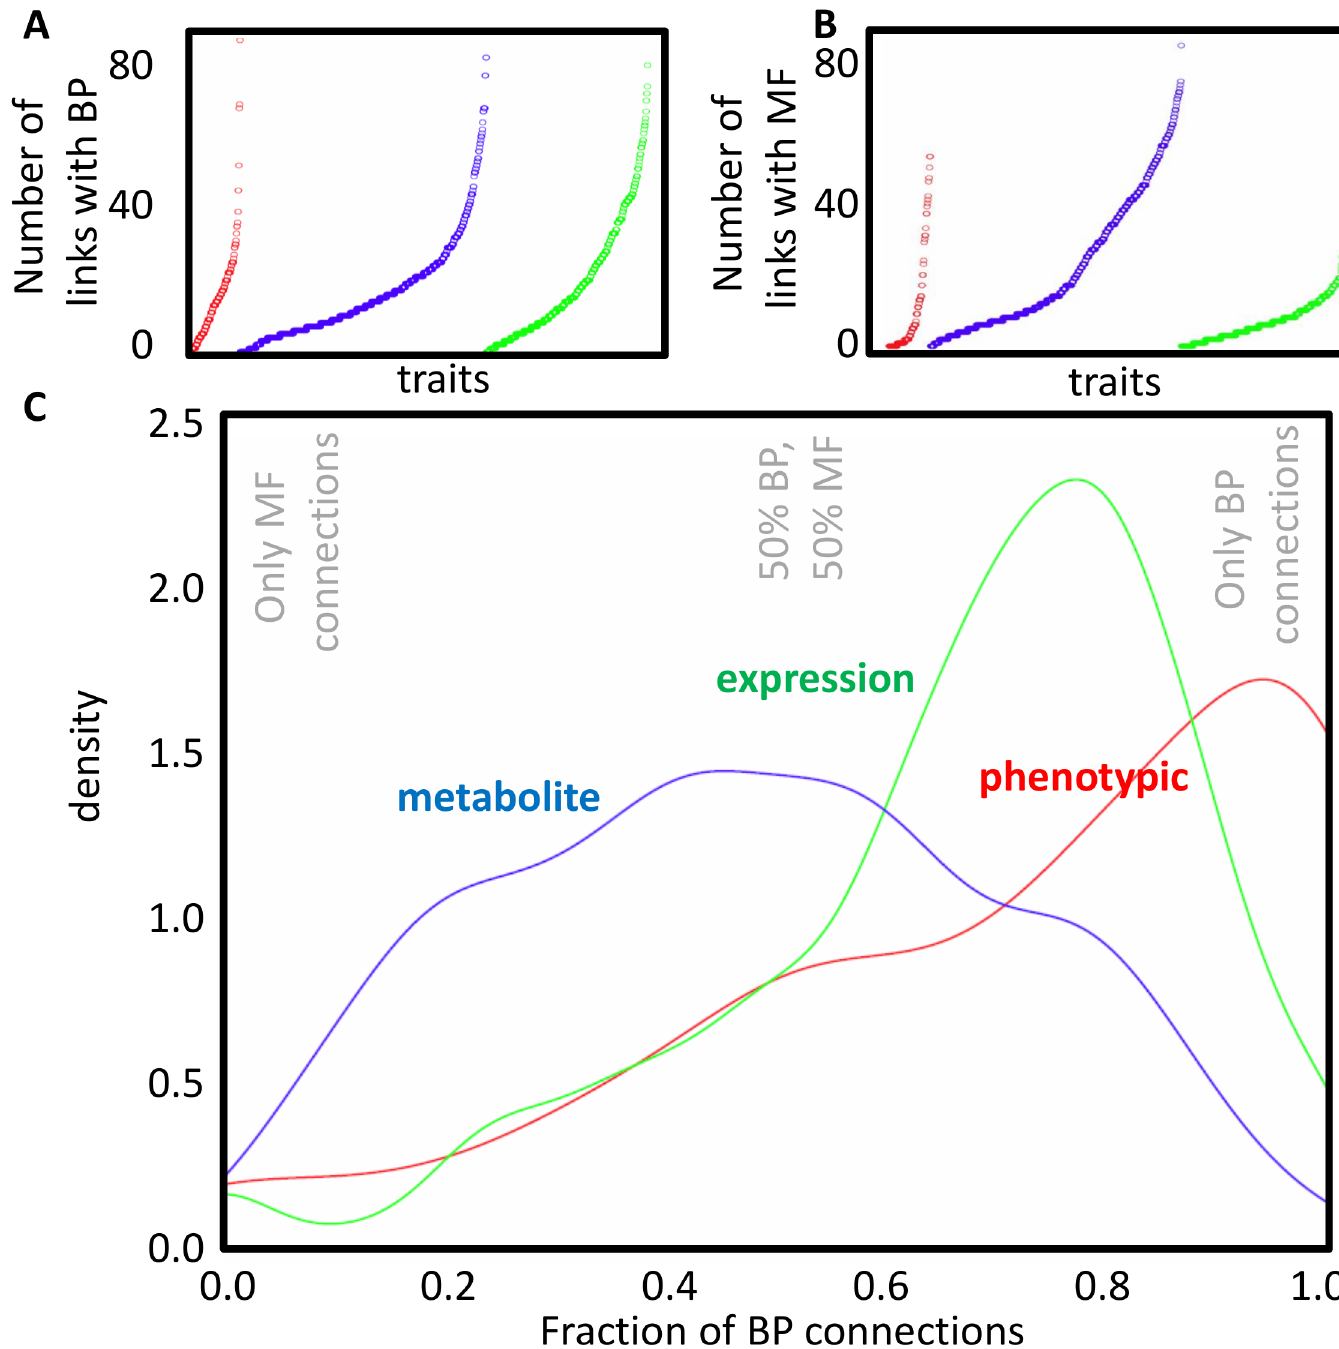
Fig 3. Distribution of the number of connections between traits and gene function terms. (A-B) The number of links with GO terms for different traits. Macroscopic traits (red), metabolitetraits (blue) and expressiontraits (green)are placed consecutively along the horizontalaxis. Within each category, traits were ordered(left to right, low to high) basedon the number of connections with BP terms (A) or MF terms (B). (C) Distributionof the fraction of BP connections (number of BP connections/(number of BP connections + number of MF connections), for macroscopic traits (red), expressiontraits (green), and metabolictraits (blue). As indicatedwith the grey legendin the figure, a fraction of BP connections of 0 correspondswith only MF connections, and a fraction of BP connections of 1 corresponds with only BP connections.